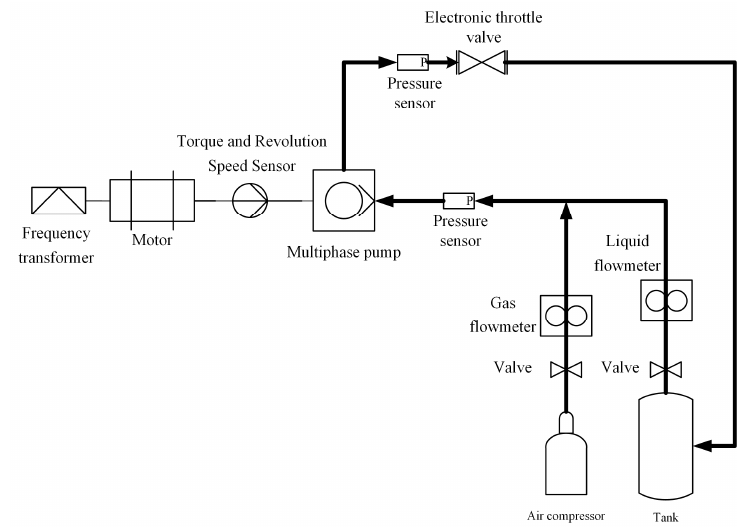
Figure 20. Experimental scheme for the multiphase pump.